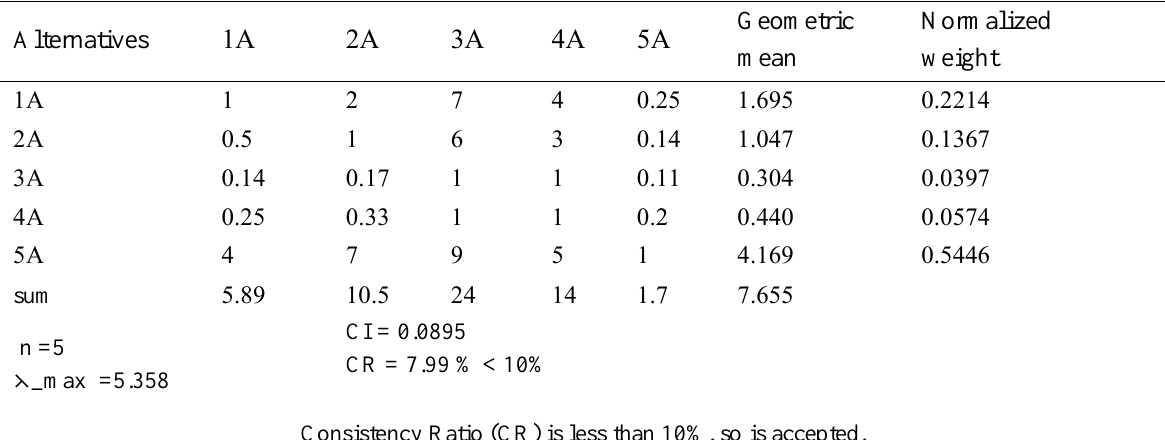
Table 7. Comparison Matrix of Alternatives with respect to